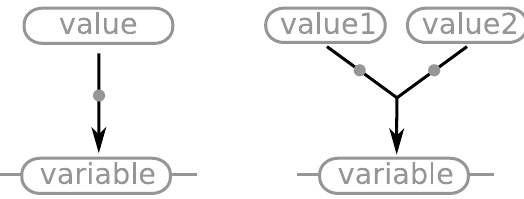
Figure 2.13: The Entity Relationship glyph for assignment .